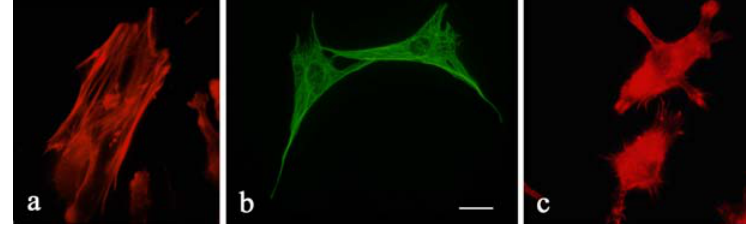
FIGURE 1 . Immunofluorescence micrographs of cytoskeleton elements in mouse bone marrow–derived macrophages. (a) Rhodamine-phalloidin labeling of hepatitis virus– induced stress filaments, (b) microtubule labeling with monoclonal antibody, and (c) rhodamine-phalloidin labeling of actin filaments after EMF exposure to 1 mT for 72 h. No changes in the arrangement of cytoskeleton elements could be detected. Bar = 10